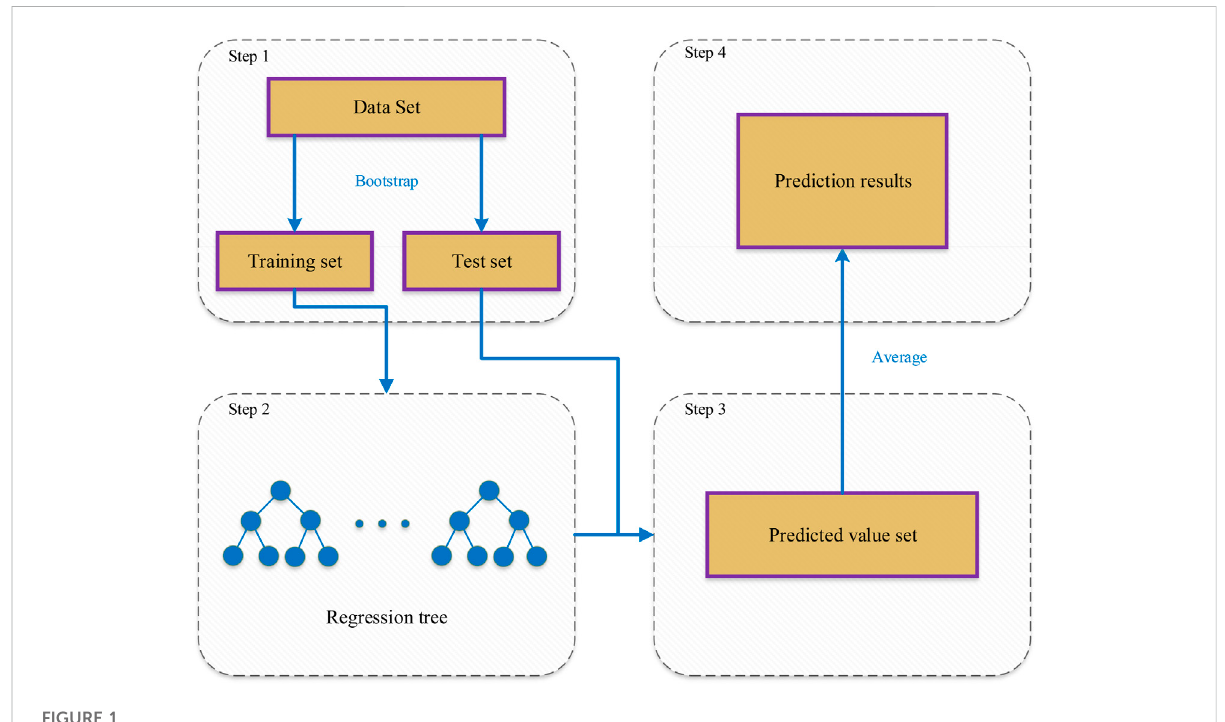
FIGURE 1 RF algorithm model structure.